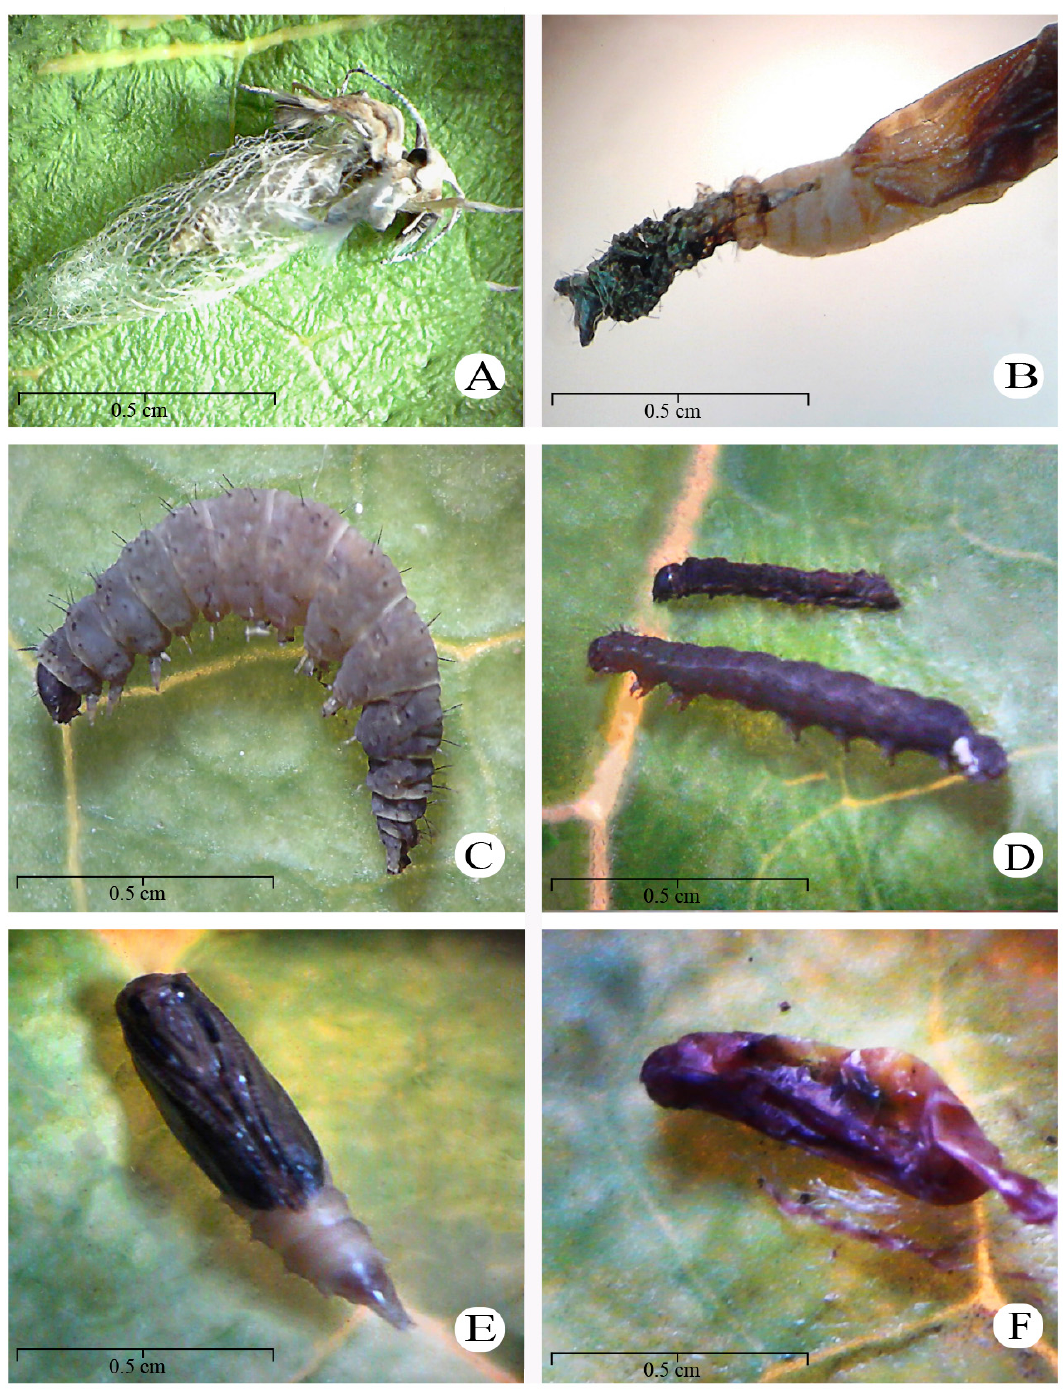
Figure 3. Deformities were observed in adults ( A ), pupae ( B , E , F ), and larvae ( C , D ) of Plutella xylostella . ( A , D , F ) show the effects of Alibertia sessilis ; ( B , C , E ) show the effects of Alibertia intermedia .